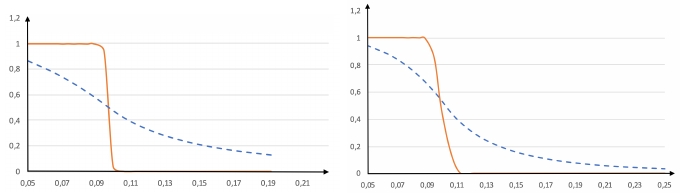
Figure 5. P 2 versus P 4 (left) and P 1 versus P 4 (right) for the Runge function with α = 2000. Comparison between the statistical frequencies (full) and the probabilistic law (2.7) (dotted). 500 meshes are used for each value of h .